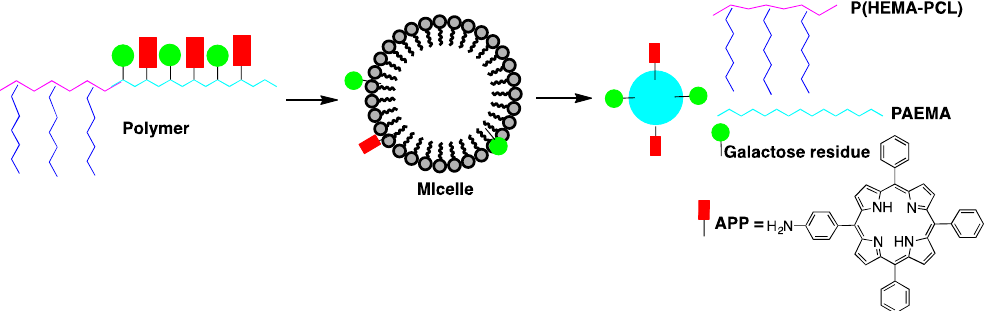
Figure 1. Schematic illustration of the core–shell micelle self-assembled from